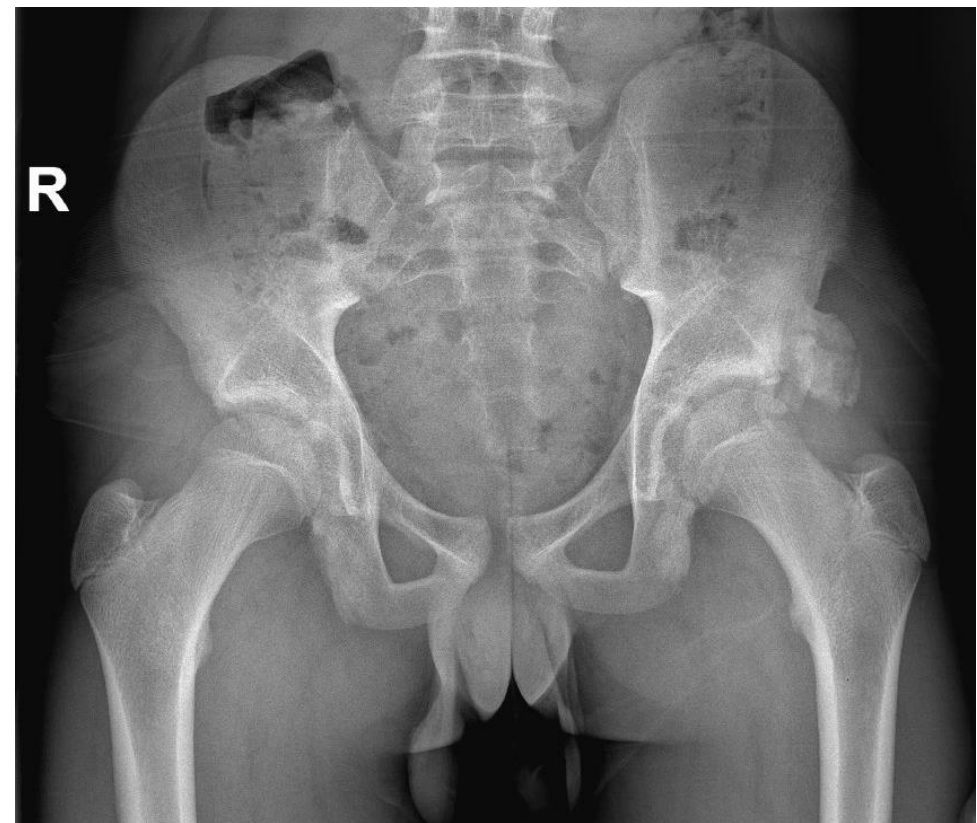
Figure 1. X-ray of the pelvis 2 months after an avulsion of the origin of the left rectus femoris tendon, showing a big osseous calcification on the anterior inferior iliac spine. (Only relevant findings are described).